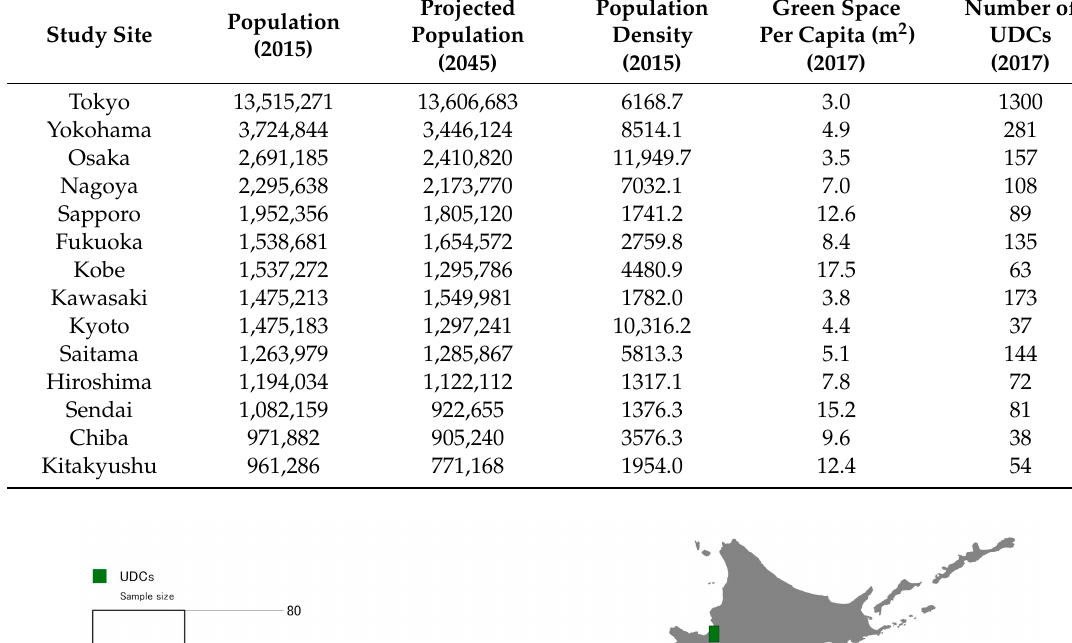
Table 2. Overview of study site characteristics [48–51].